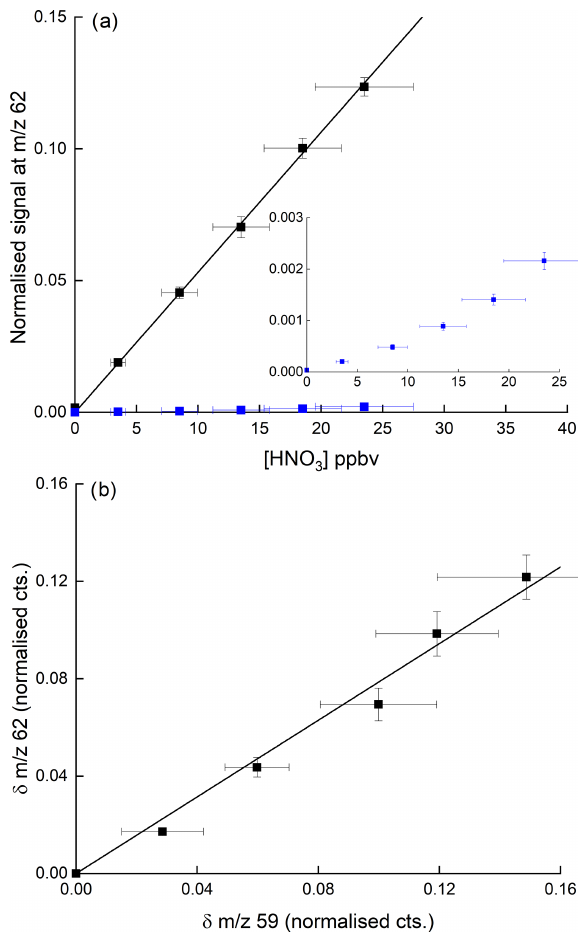
Figure 9. (a) Detection of HNO 3 at m/z 62 in the presence of 3.25ppbv PAA (and thus the acetate anion, CH 3 CO 2 ). The blue data points (expanded view in the inset) were obtained in the ab- sence of PAA, whereby detection of HNO 3 at m/z 62 is inefficient. The error bars are 1 σ statistical uncertainty in the signal at m/z 62 and 17% total uncertainty in the HNO 3 mixing ratio. (b) Change in normalised signals at m/z 62 and m/z 59 upon adding HNO 3 for the same dataset (i.e. background corrected signals). The error bars are 1 σ statistical